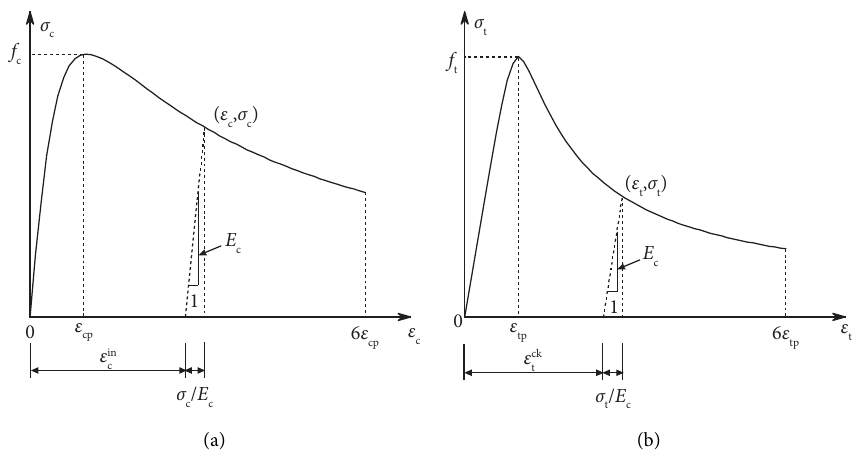
Figure 5: Te uniaxial stress-strain relationship of concrete. (a) Compression. (b) Tension.